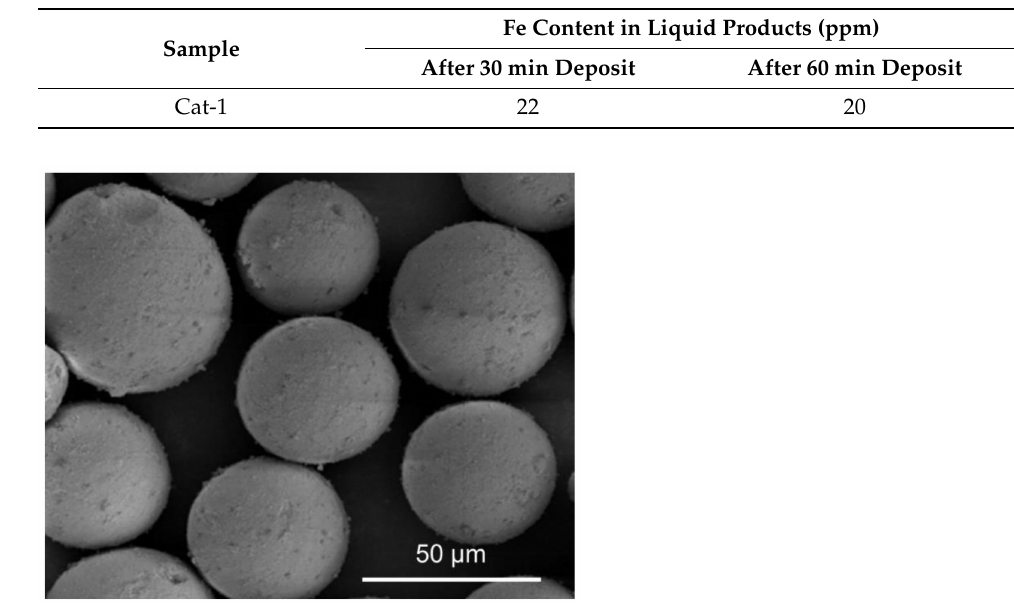
Figure 6. TEM images and size distributions of ( a , b ) Cat-1 and ( c , d ) SFT-3. Table 8. Fe content in liquid products of Cat-1.